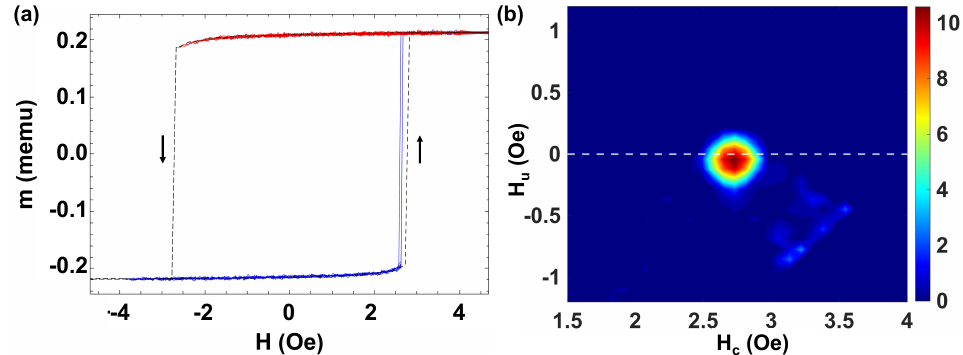
Figure 2. ( a ) MHL and FORC curves for a single Fe 77.5 B 15 Si 7.5 bistable microwire with H c = 2.73 Oe when an axial magnetic field is applied. ( b ) Corresponding FORC